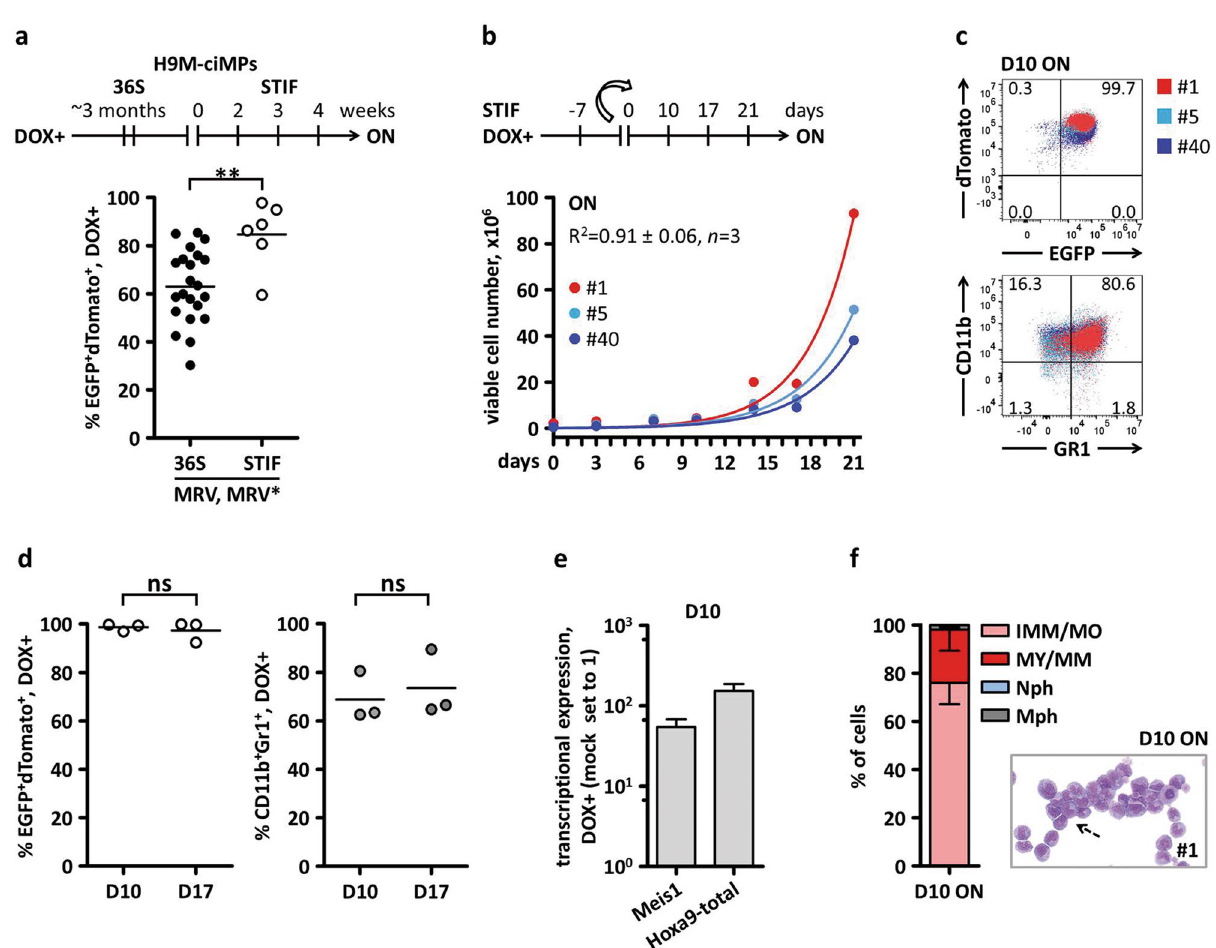
Figure 3. Selection and characterisation of H9M-ciMPs under stem cell maintaining conditions and doxycycline application. ( a ) Schematic presentation of H9M-ciMP selection under stem cell maintaining conditions (STIF) and 1 µg/mL doxycycline (ON) supplementation. H9M-ciMPs resulting from MRV or MRV* experiments were cultured under STIF conditions. MRV, MRV*, multimodal retroviral vectors with or without LM-PCR linker, respectively. Each data point represents the result of an individual cell line. Horizontal lines represent the mean values. ( b ) Exponential growth equation for H9M-ciMPs cultured under STIF/ON conditions. R 2 , the R-squared value. ( c ) Dot plot overlays to present expression of CD11b + Gr-1 + in H9M-ciMPs at day 10 of culture under STIF/ON conditions (frequency percentages are given for H9M-ciMP cell line #1). ( d ) Percentages of EGFP + dTomato + and CD11b + Gr-1 + cells for D10/ON and D17/ON STIF conditions, n = 3. Each data point represents the result of an individual cell line. Horizontal lines represent the mean values. ns, not significant, p > 0.05 (non-parametric two-tailed Mann–Whitney test). ( e ) Histogram presentation of relative transcriptional expression of Meis1 and Hoxa9 (corresponds to Hoxa9 -total) in H9M-ciMPs. Expression levels in non-transduced non-cultured lineage negative cells (Mock) were set to 1. Data are represented as mean ± SD, n = 3. ( f ) Histogram presentation of differential cell count for H9M-ciMPs under STIF/ON conditions. IMM/ MO, immature cells: myeloblast-, promyelocyte-, monoblast-, promonocyte- and monocyte-like cells; MY/ MM, myelocyte-, metamyelocyte-like; Nph, band neutrophil, segmented neutrophil; Mph, macrophage. Data are represented as mean ± SD, n = 3. H9M-ciMPs, conditionally immortalised myeloid progenitor cell lines engineered to co-express Hoxa9 and Meis1. D, day. For ( b ) and ( c ) H9M-ciMPs #1, 5 and 40 are marked in red, light blue and blue, respectively. ( a , d ) generated in Prism 5 (GraphPad software, San Diego, CA); ( c ) generated in PowerPoint using plots from Flowjo 10 (Tree Star, Ashland,